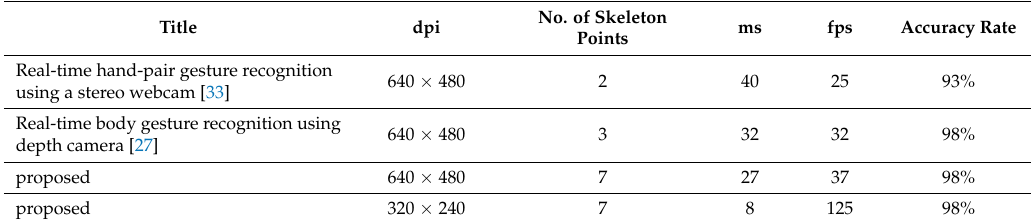
Table 6. Comparison with two